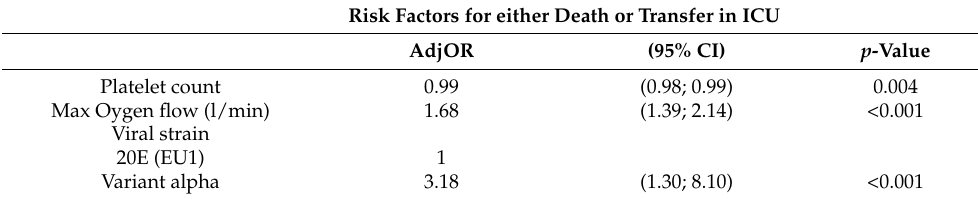
Table 4. Risk factors for either death or transfer in the